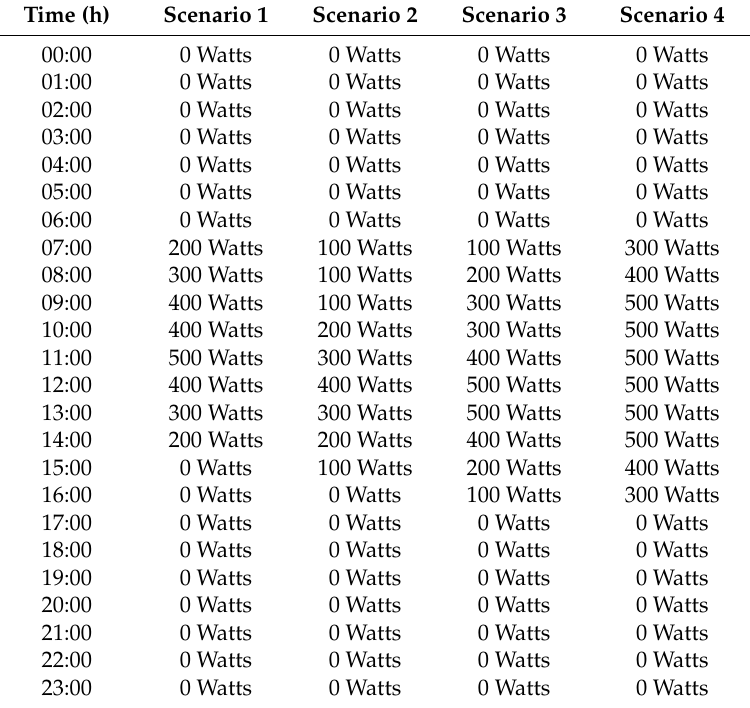
Table 5. PV power profiles.